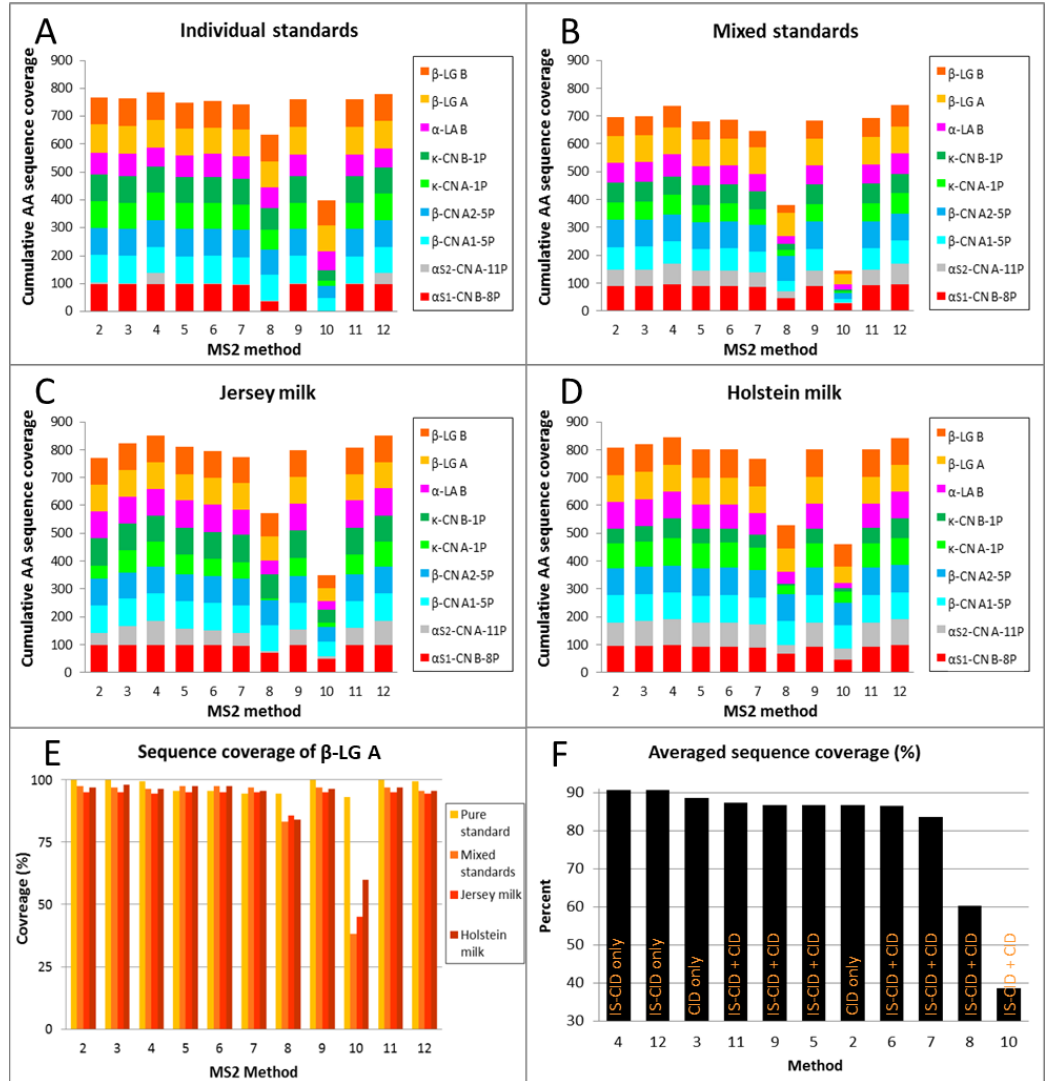
Figure 4. Comparison of the 11 MS/MS methods based on the AA sequence coverage in percent of the nine most prominent milk proteins. ( A ) Cumulative coverage in the individual standards. ( B ) Cumulative coverage in the mixed standards. ( C ) Cumulative coverage in the Jersey milk sample. ( D ) Cumulative coverage in the Holstein milk sample. ( E ) Illustration of AA sequence coverage for one particular protein, β-LG A, in increasingly complex samples. ( F ) Averaged sequence coverage for all eight proteins sorted by method efficacy; the fragmentation modes are reported as well.